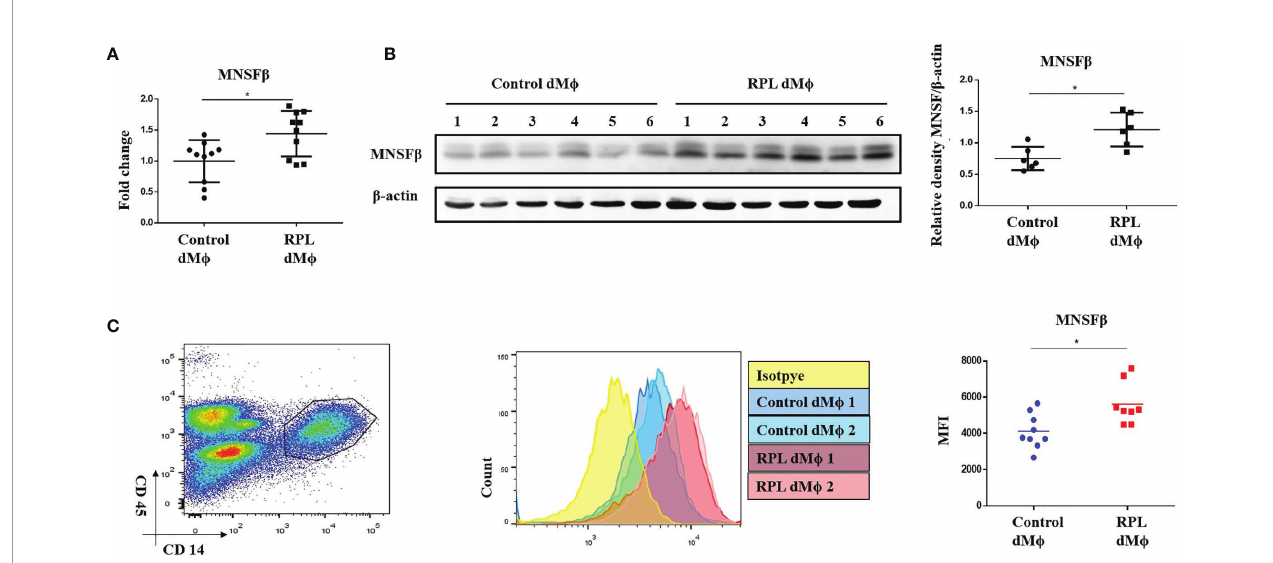
FIGURE 2 | Alteration of the MNSF b expression in human dM f from RPL patients in the fi rst trimester. (A) MNSF b mRNA expression levels in dM f from Control women ( n = 10) and RPL patients ( n = 10) as detected by real-time RT-PCR analysis (normalized to the mRNA expression of Gapdh). (B) MNSF b protein expression levels in dMf from Control women ( n = 6) and RPL patients ( n = 6) as detected by Western blotting analysis (normalized to the expression of b-actin). Left panel: Representative images of Western blotting assay; right panel: the relative density of MNSFb/b-actin. (C) MNSF b protein expression levels in dM Ф from Control women ( n = 9) and RPL patients ( n = 8) as detected by fl ow cytometry. Left panel: fl ow cytometry analysis of dM Ф with antibodies against CD45 and CD14; middle panel: representative images of the fl ow cytometry assay; right panel: the mean fl uorescence intensity (MFI) of MNSF b as detected by fl ow cytometry. (Control dM Ф : dM Ф isolated from decidual tissues of normal women in early pregnant; RPL dM Ф : dM Ф isolated from decidual tissues of RPL patients, * p <